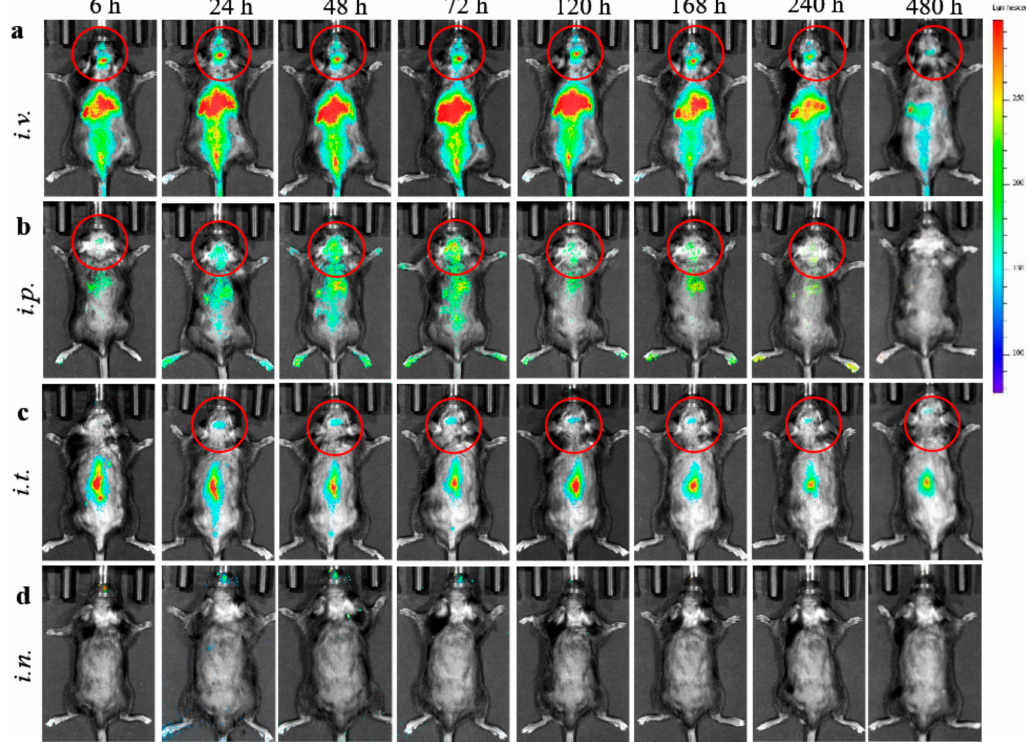
Figure 1. Biodistribution of 1,1’-Dioctadecyl-3,3,3’,3’-tetramethylindo-carbocyanine iodide (DIR)- extracellular vesicles (EVs) in CLN2 KO mice by IVIS. DIR-labeled EVs were administered in BD mice (1 month old, N = 4), though: ( a ) i.v. (6 × 10 11 particles / 200 µ L), ( b ) i.p. (6 × 10 11 particles / 200 µ L), ( c ) i.t. (1.5 × 10 11 particles / 50 µ L), or ( d ) i.n. (6 × 10 10 particles / 20 µ L) routes, and imaged up to 480 h. Prone representative images show prolonged DIR signal accumulation in the brain for i.v. , i.p. , and i.t. administration routs, especially at 24–120 h. Little, if any, DIR signal was observed in live animals after i.n. administration ( d ). Accumulation of labeled EVs was also observed in the main peripheral organs for i.v. and i.p.